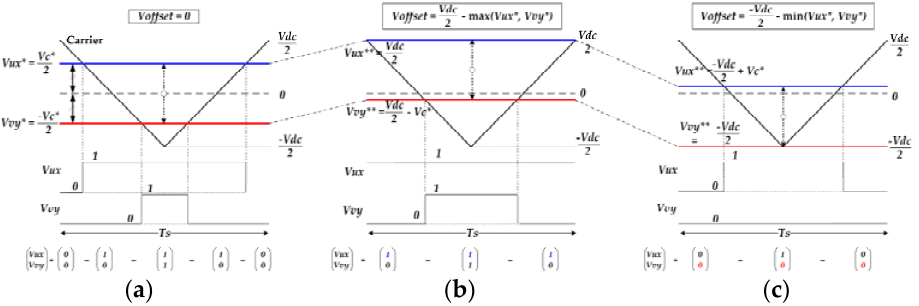
Figure 4. Typical switching sequence according to the PWM methods: ( a ) conventional CB ‐ SPWM, ( b ) proposed DPWM with UCM, and ( c ) proposed DPWM with LCM. 3. Proposed Discontinuous Pulse ‐ Width Modulation (DPWM) for Single ‐ Phase PWM Converter